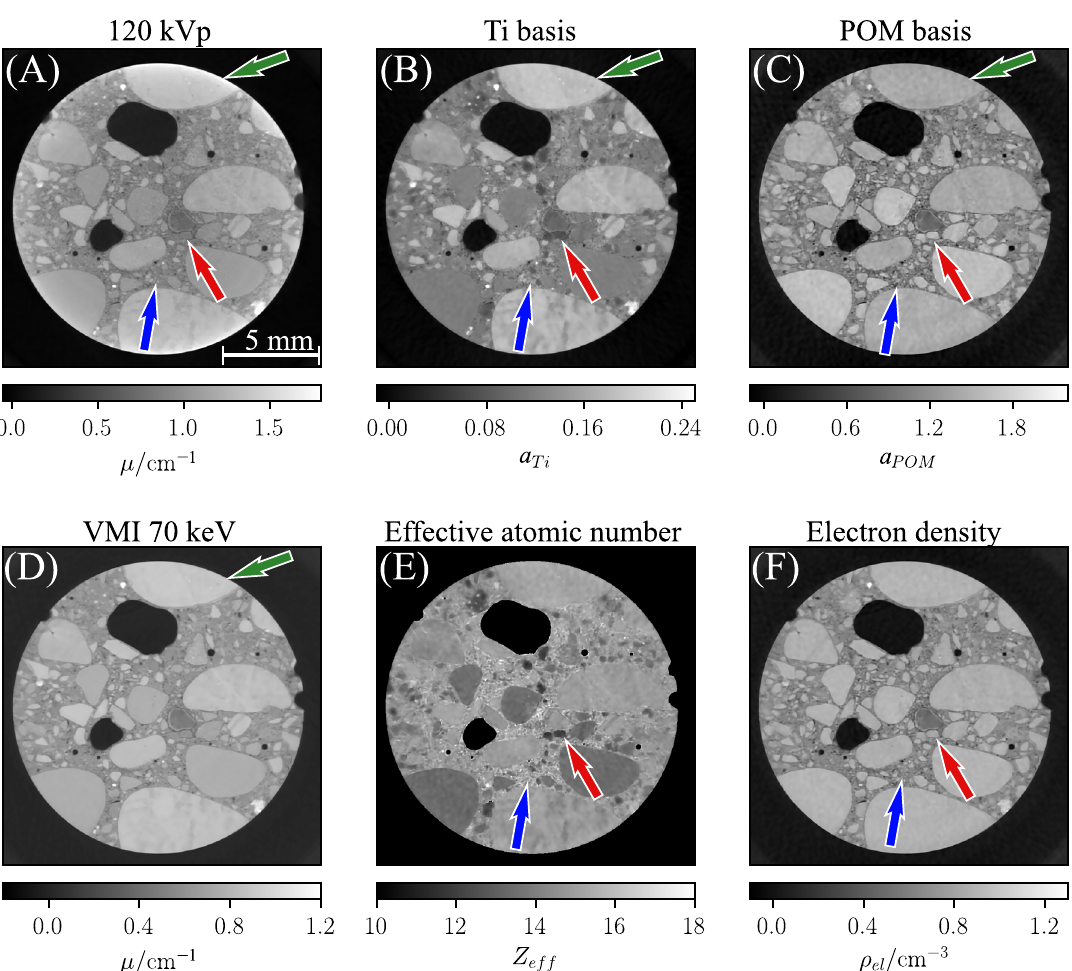
Fig 6. Conventional and spectral CT images of a concrete drill core. The conventional image (A) depicts the attenuation of the polychrmoatic spectrum, while the decomposed basis material images show the volume fractions of titanium (B) and POM (C). (D) gives the sample’s attenuation value at 70 keV. (E) and (F) depict the spatial distribution of the effective atomic number and the electron density within the sample,